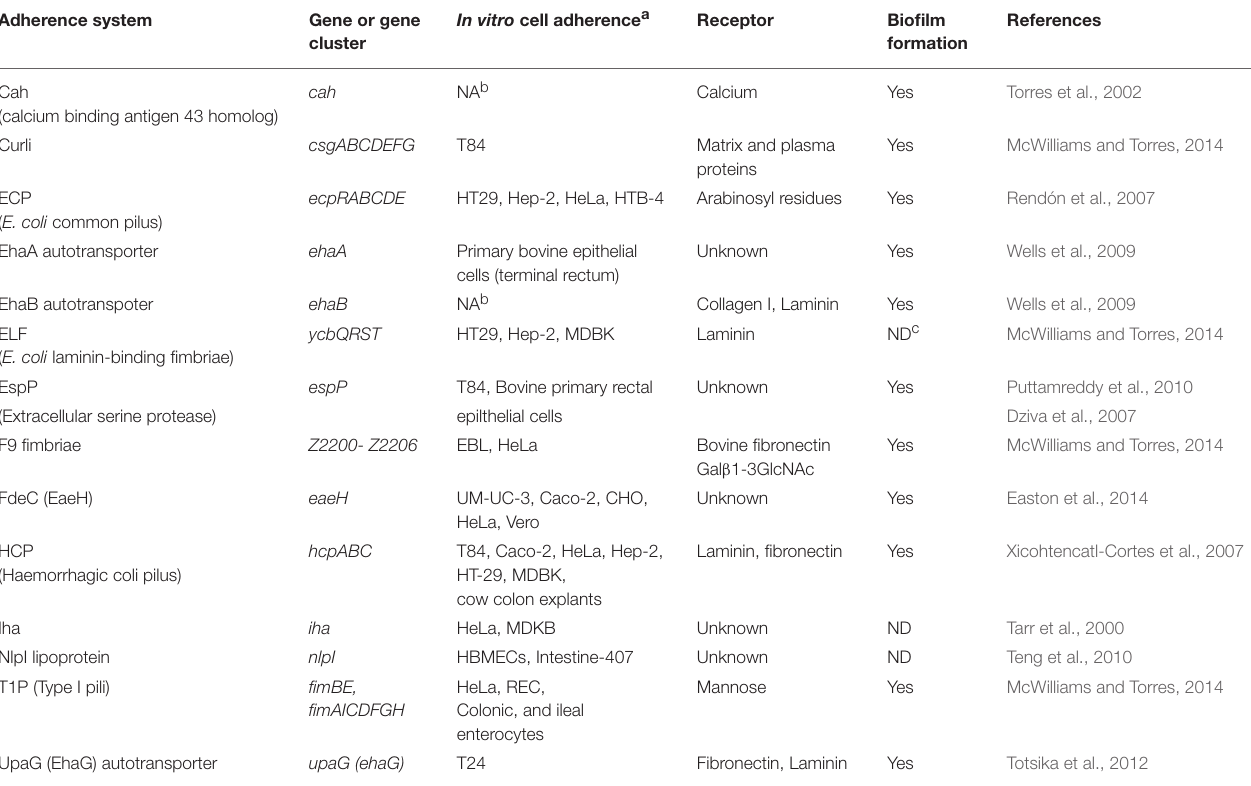
TABLE 1 | Adherence systems encoded by the E. coli MC2